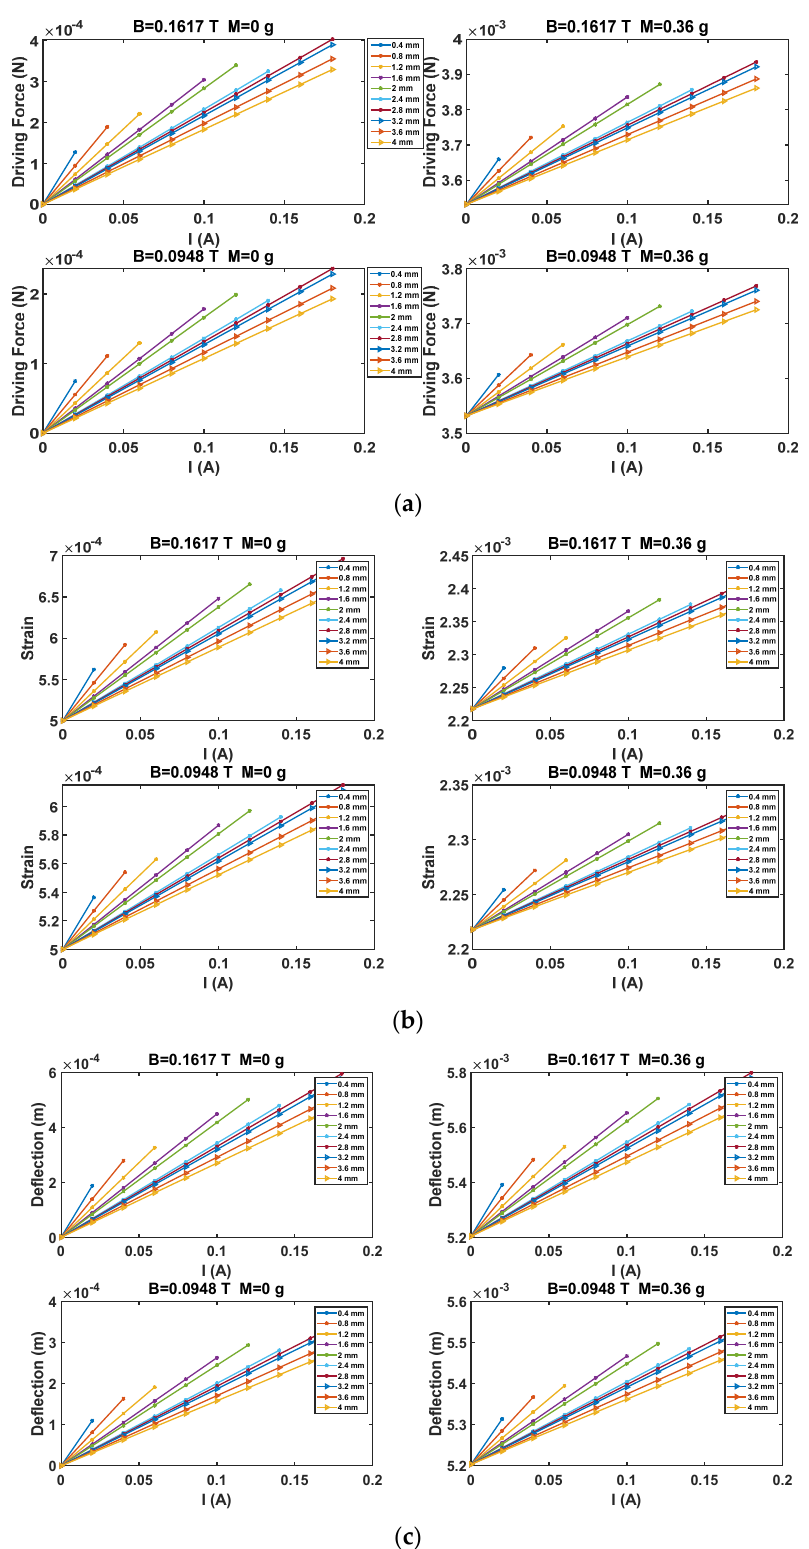
Figure 3. The actuation force ( a ), the strain ( b ), and the deflection ( c ) of the beam, as a function of the driving current, the coil track width, and two B intensities (0.0948 T, 0.1617 T). Results for two values of the target mass (0 and 0.36 g) are shown.